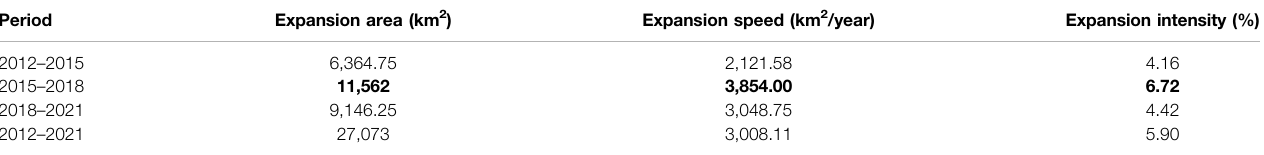
TABLE 6 | Expansion of China ’ s urban built-up areas from 2012 to 2021.